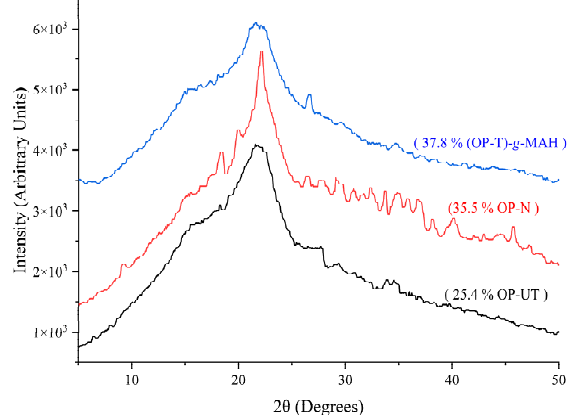
Figure 7. XRD patterns of OP-UT, OP-T, and (OP-T)- g -MAH.